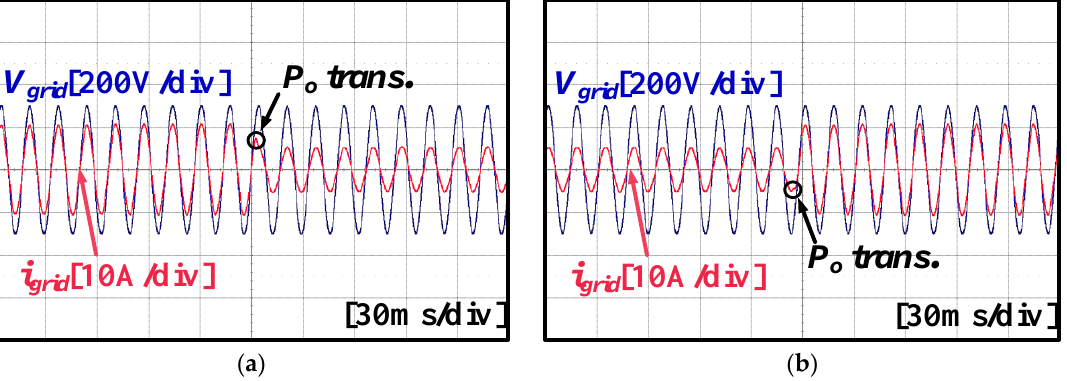
Figure 17. Step responses of the proposed inverter at V in = 400 V DC , V grid = 220 VAC/60 Hz, f s = 20 kHz, and Q o = 0 VAR: ( a ) for a decrease of P o from 2 kW to 1 kW and ( b ) for an increase of P o from 1 kW to 2 kW.